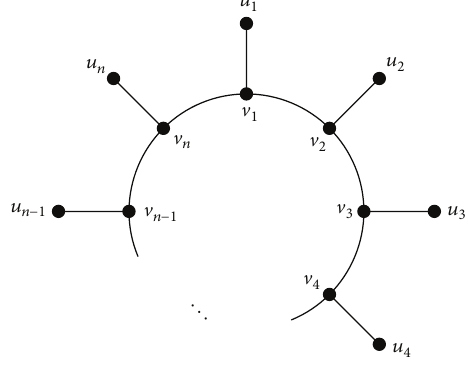
Figure 1: The crown 𝐶 𝑛 ⊙ 𝐾 1